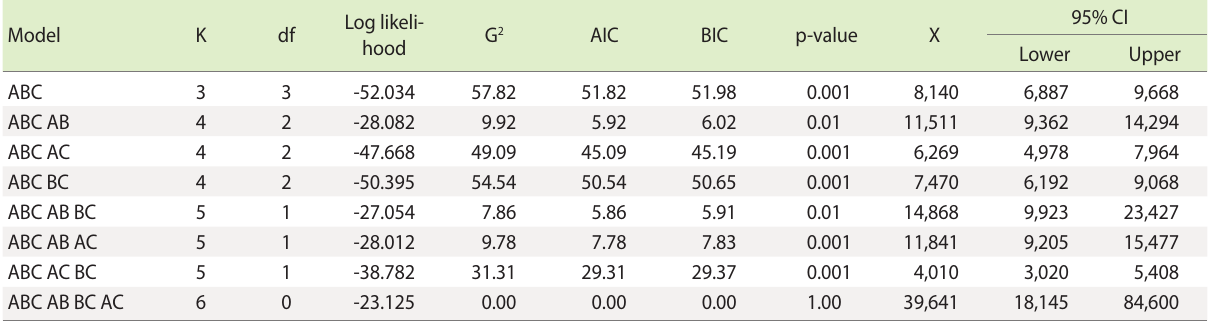
Table 2. Log-linear models fitted to the 3 lists of HIV-positive patients registered in the 3 data sources and the estimated number of unreg- istered HIV-positive individuals